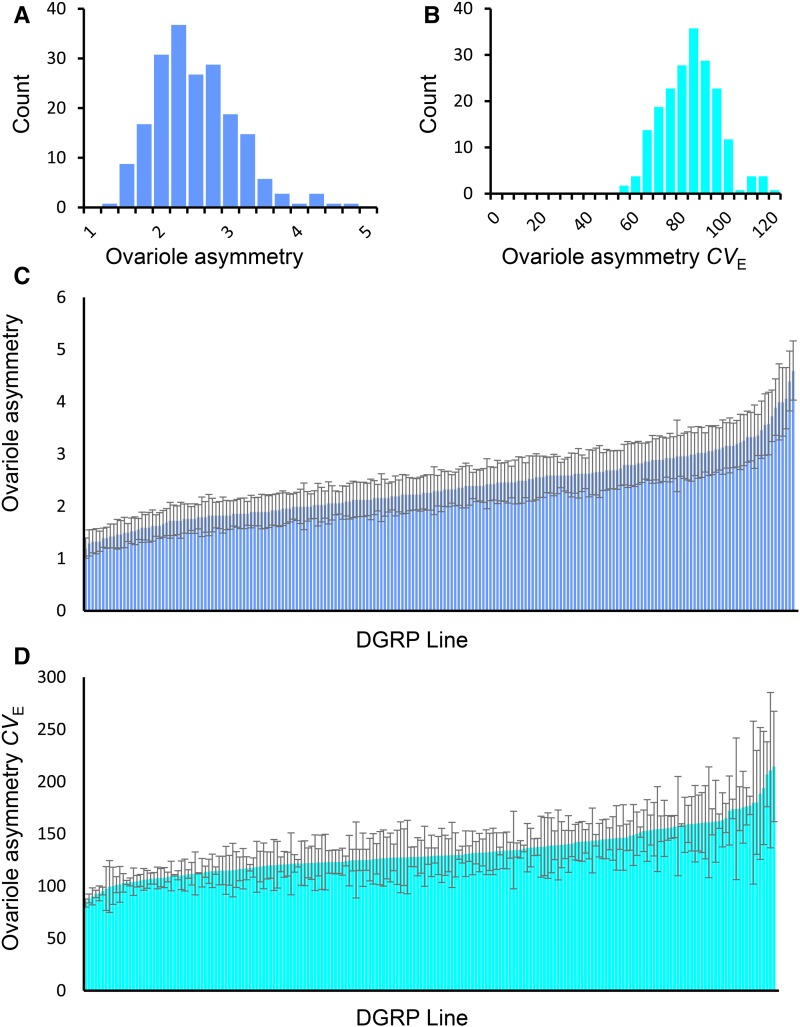
Variation in ovariole asymmetry in the DGRP. Histogram of (A) ovariole asymmetry and (B) ovariole asymmetry CVE line means. Mean and SE of (C) ovariole asymmetry and (D) ovariole asymmetry CVE.